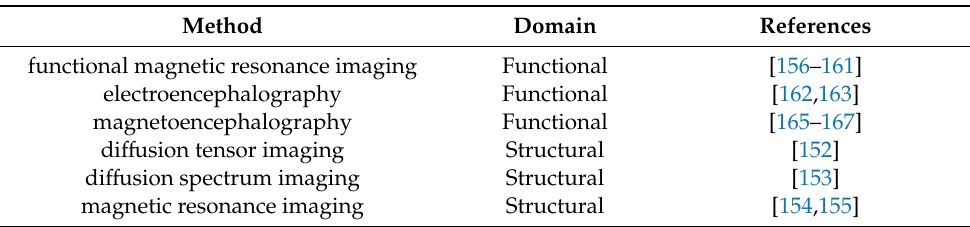
Table 2. Methods used for human brain